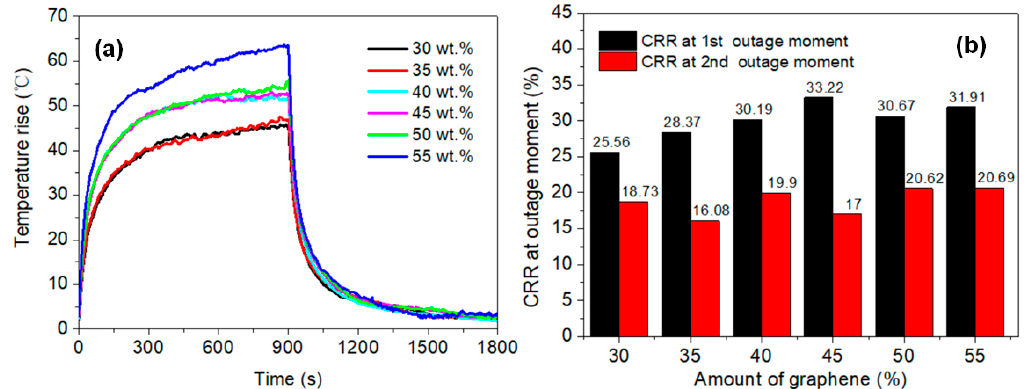
Figure 12. Electric heating performance (second heating test) of the 16 g·m − 2 membranes with different amounts of graphene. ( a ) Temperature rise and ( b ) change rate of resistance (CRR) at the outage moment.